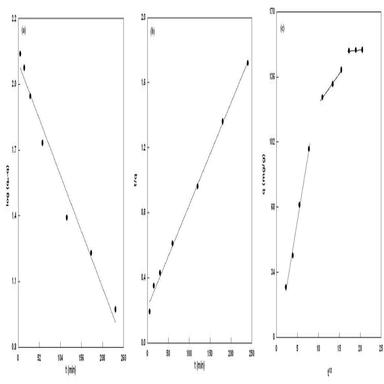
(a) PFO, (b) PSO, (c) W-M plots of 2,4-D adsorption onto FLPWAC composite.